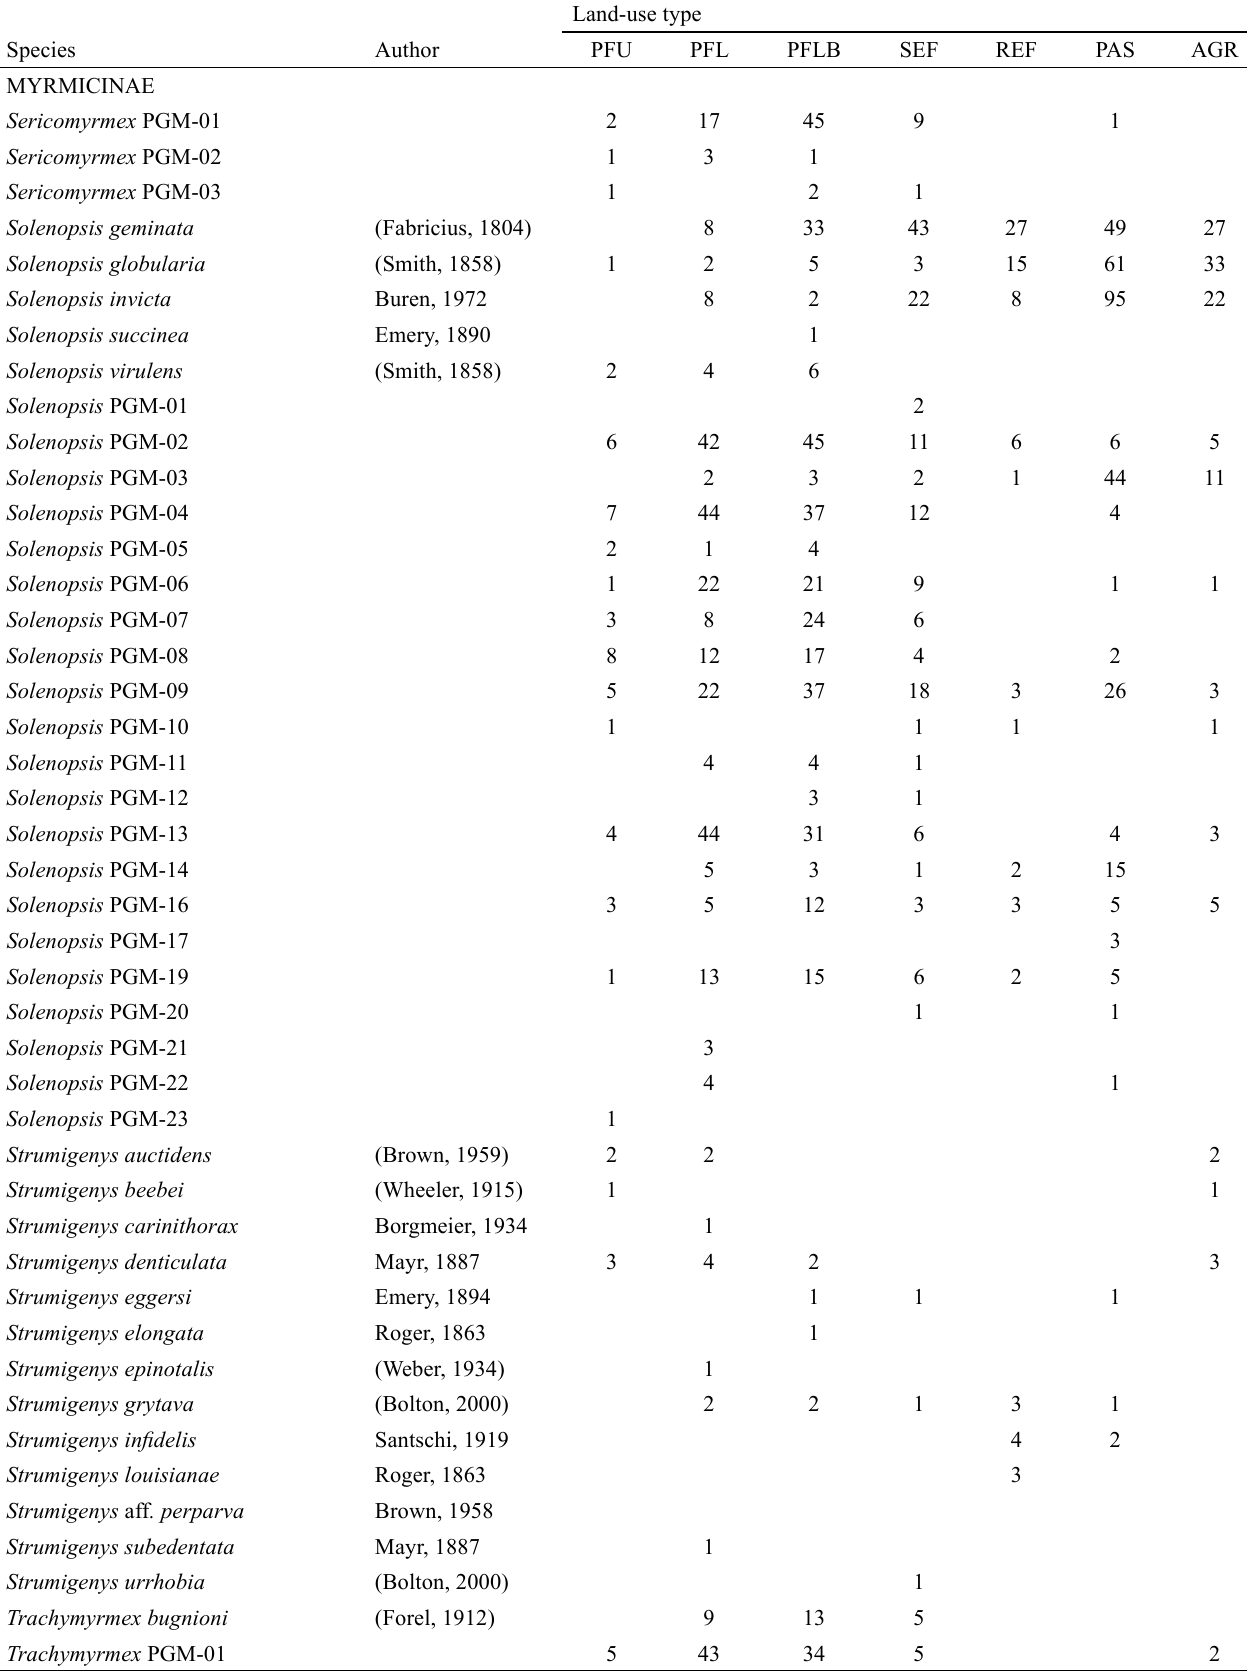
Table 2 . List of ant species collected in this study. Values represent number of records per pitfall traps of each species in each land-use type: PFU – primary forest undisturbed, PFL – primary forest logged, PFLB – primary forest logged and burnt, SEF – secondary forest, REF – reforestation with commercial species, PAS – pasture, AGR – agricultural areas.